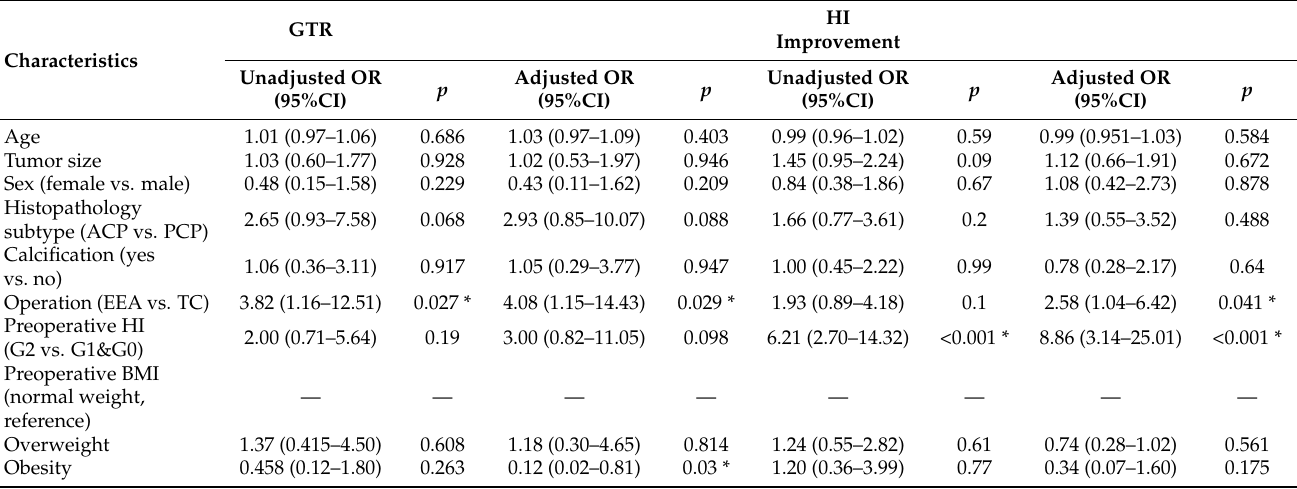
Table 2. Independent factors for the extent of surgical resection and improved hypothalamic involve- ment. After adjusting for age, tumor size, sex, histopathology subtype, calcification, preoperative hypothalamic involvement, and preoperative body mass index, the EETS was independently associ- ated with a higher rate of gross total resection (aOR = 4.08, p = 0.029) and improved hypothalamic involvement (aOR = 2.58, p = 0.041). uOR, unadjusted odd ratio; aOR, adjusted odd ratio; —, not report; * means p < 0.05.